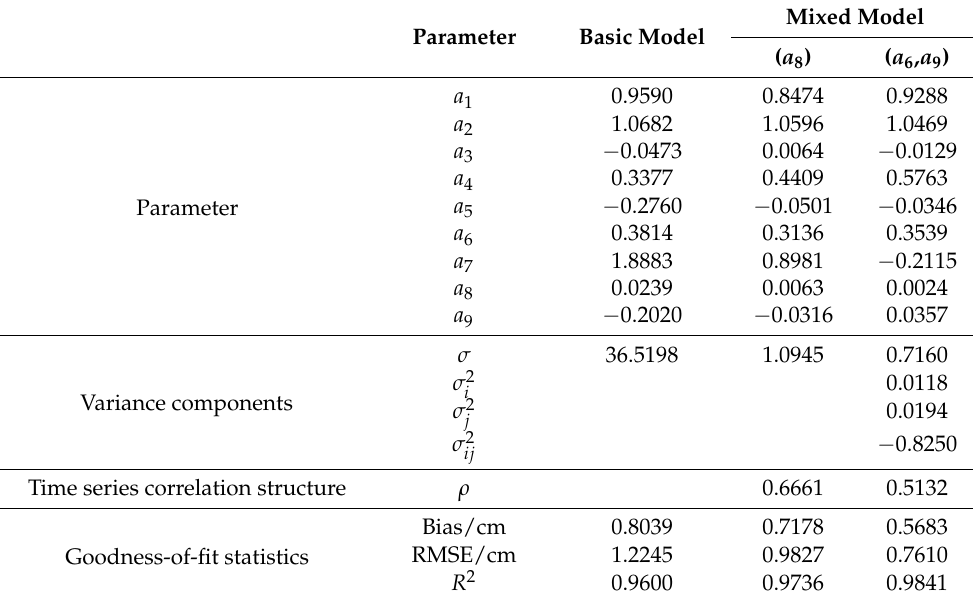
Table 10. Parameters, variance estimates and fitting statistics of different models.